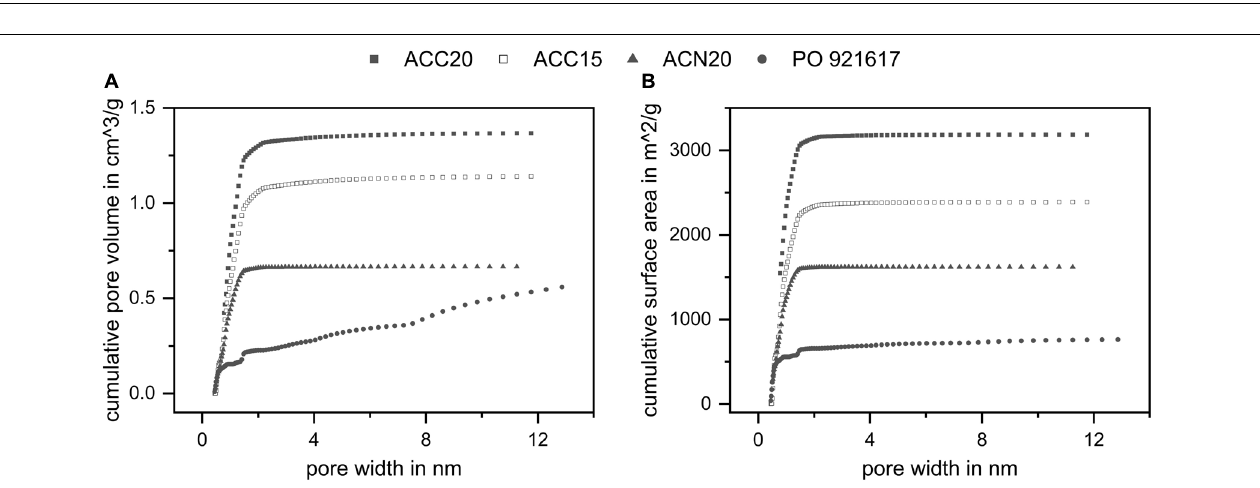
FIGURE 2 | Scanning electron microscope (SEM) images showing the macroscopic morphology differences of the used electrode materials. (A) Activated Carbon Fabrics (ACC20, ACC15). (B) Activated Carbon Felt (ACN20). (C,D) Carbon Aerogel (PO921617) in two different magnifications.